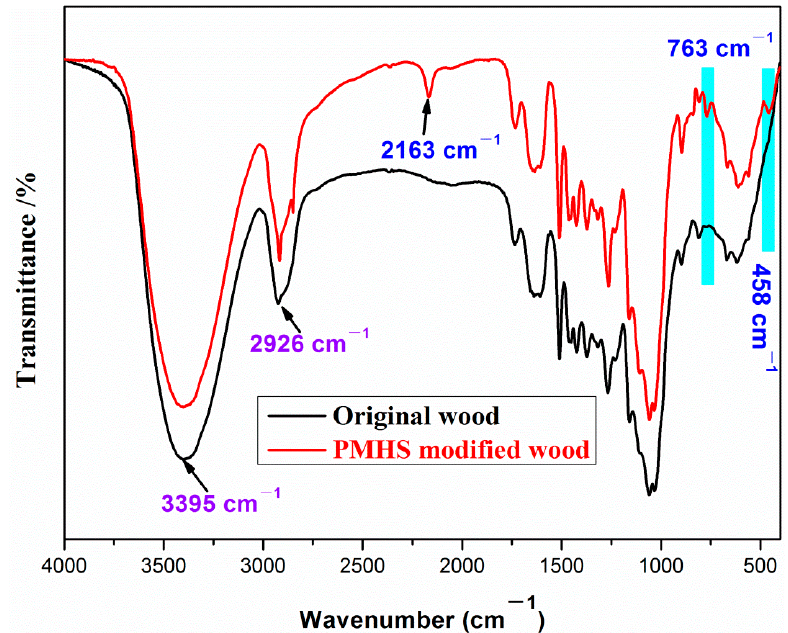
Figure 3. FTIR spectra of the original and poly(methylhydrogen)siloxane (PMHS) modified wood sample .